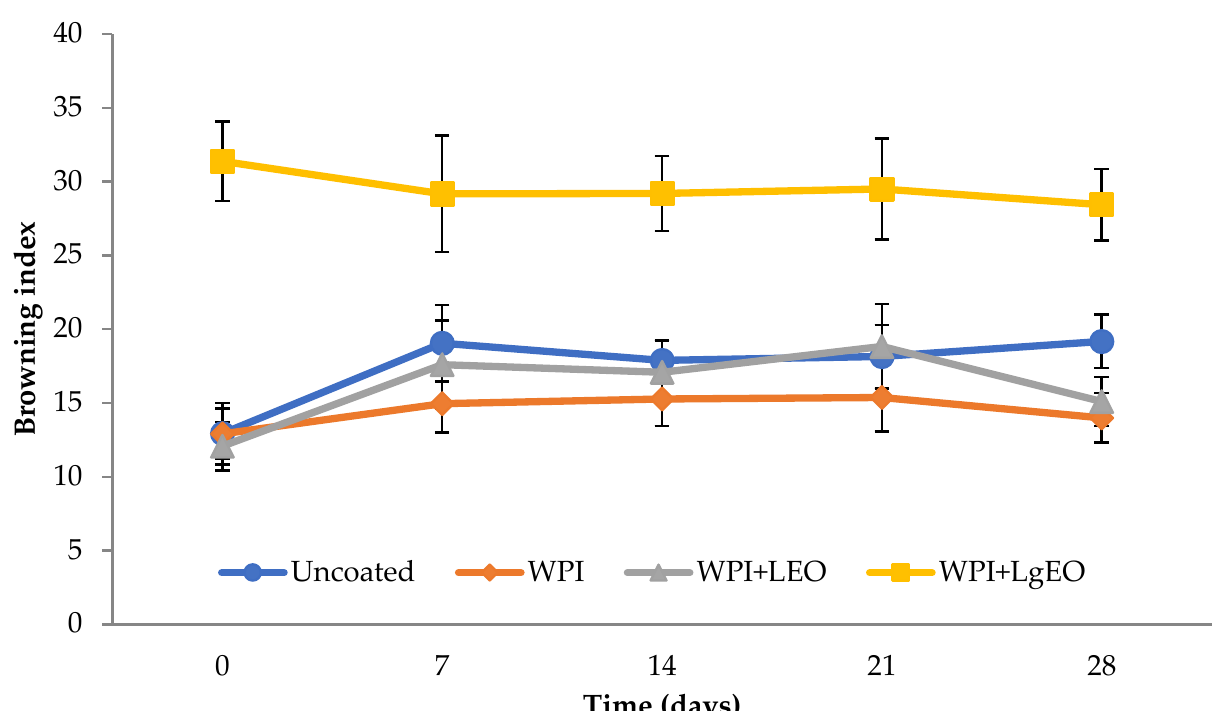
Figure 1. Lightness ( Parameter L *) of fresh-cut pears coated with whey protein isolate coatings (WPI) incorporated with lemon (WPI + LEO) and lemongrass (WPI + LgEO) essential oils or un- coated samples during 28 days of storage at 4 °C.